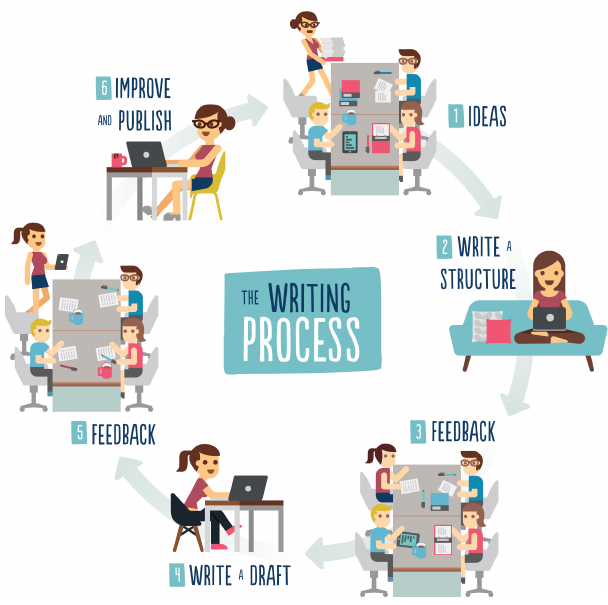
Figure 1. The ClimateSnack writing